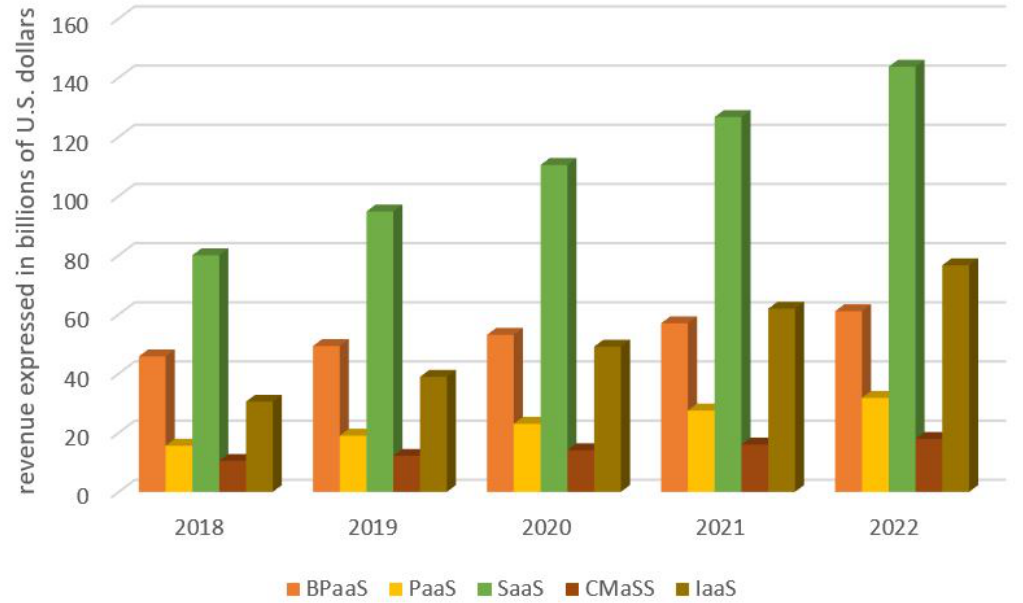
Figure 2. Gartner’s revenue predictions of the global public cloud market; BpaaS—business process as a service; CMaSS—cloud management and society services (the data used for generating the graph was adapted from